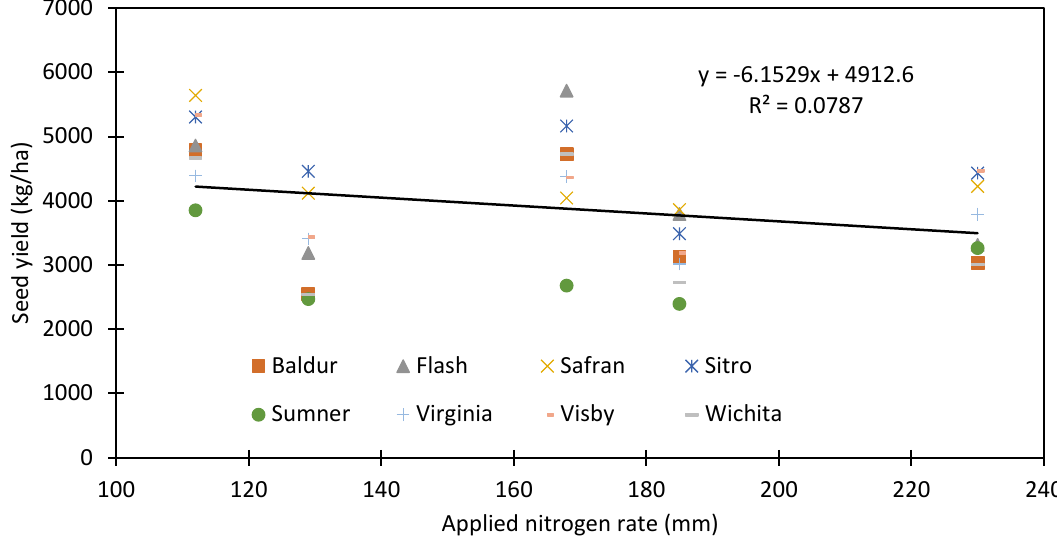
Figure 5. Relationship between winter canola seed yield and applied nitrogen amount.